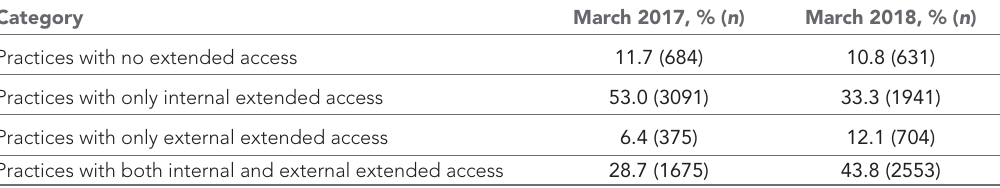
Table 3 Type or location of external access offered by